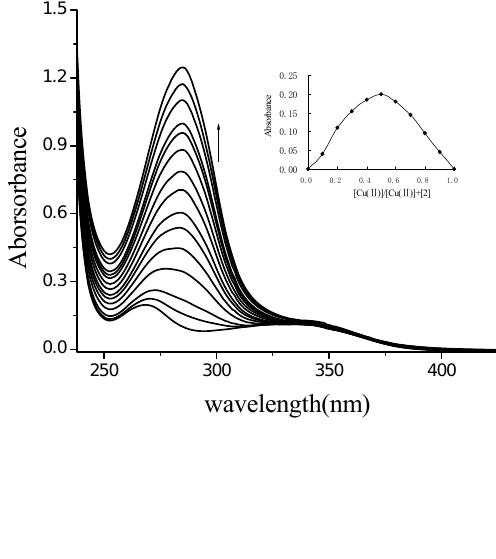
Figure 6. UV-Vis spectral changes of 2 upon the addition of Cu 2+ ion. [ 2 ] = 1.00 × 10 − 5 M, [Cu 2+ ] = 0~2 × 10 − 5 M. Inset shows the job’s plots for complexation of 2 with Cu 2+ determined by UV-Vis spectroscopy in THF. [ 2 ] + [Cu 2+ ] = 1.0 × 10 − 5 M at 298